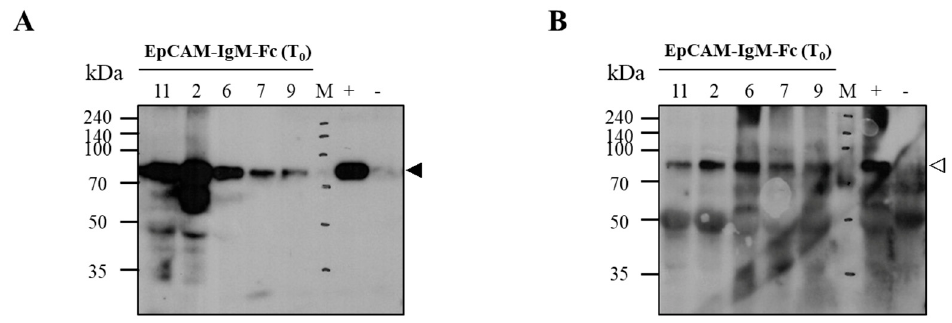
Figure 4. Immunoblot analysis to confirm the expression of EpCAM–IgM Fc in T 0 transgenic lines. ( A ) T 0 transgenic plants #2, 6, 7, 9, and 11 were tested by goat anti-IgM Fc µ -chain conjugated to HRP. M, protein marker; + , tobacco plant EpCAM–IgM Fc as a positive control; − , non-transgenic plant as a negative control. ( B ) T 0 transgenic plants #2, 6, 7, 9, and 11 were tested by mouse anti-human EpCAM as a primary first antibody and goat anti-mouse IgG 2a heavy chain conjugated to HRP as a secondary antibody. M, protein marker; + , tobacco plant EpCAM–IgM Fc as a positive control (50